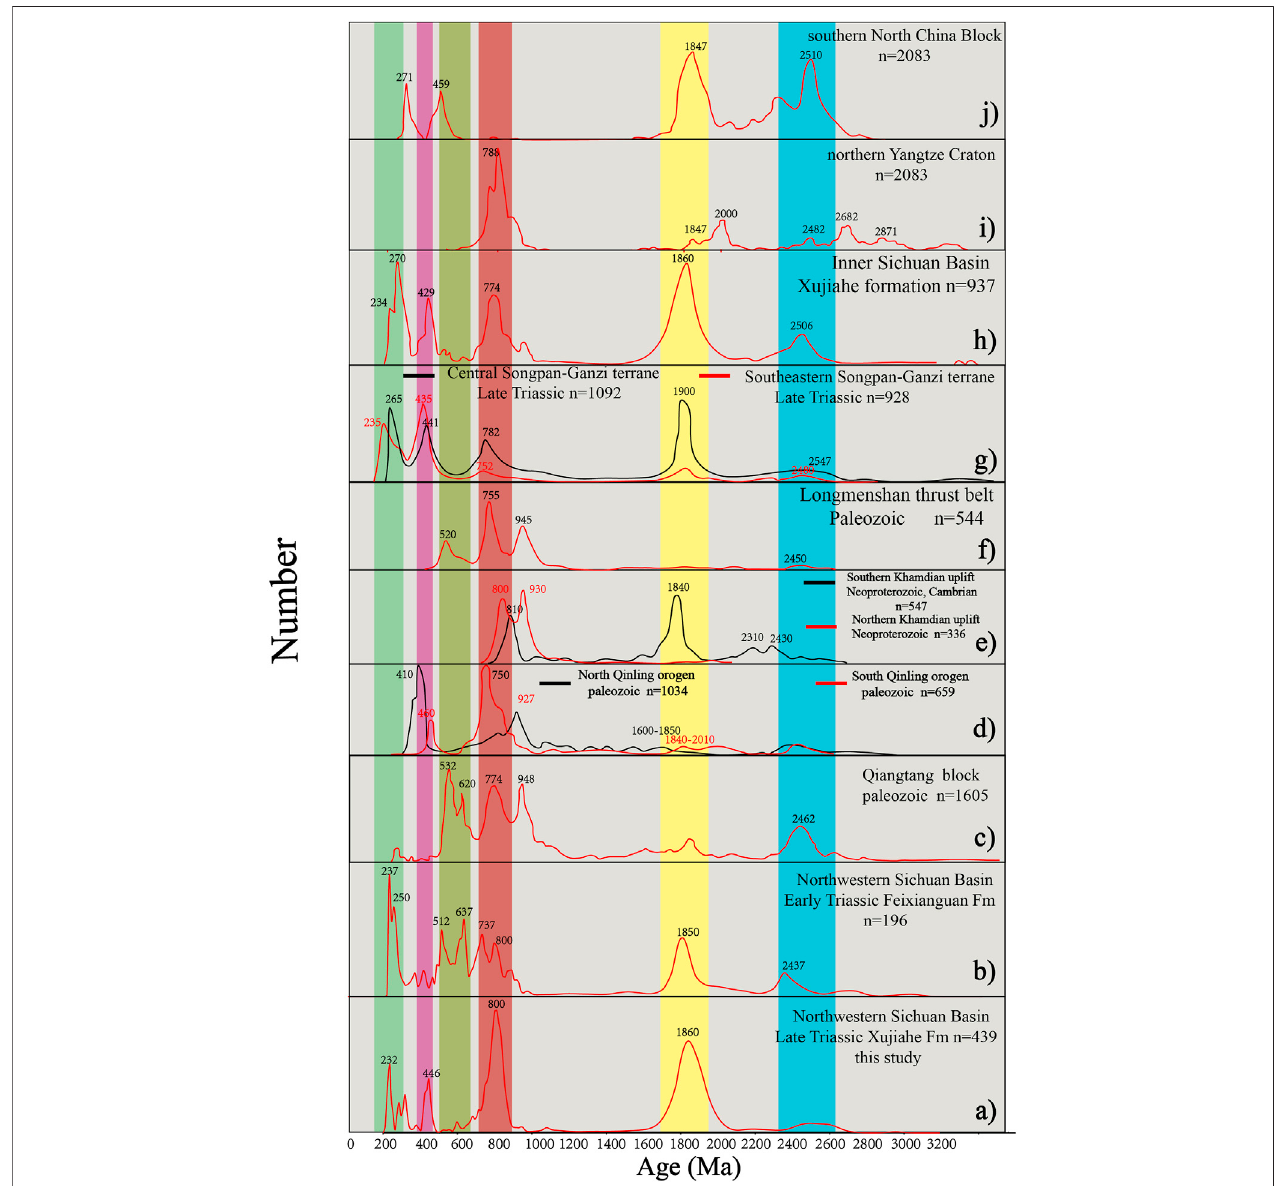
FIGURE3| RelativeprobabilityofdetritalzirconU – Pbagesforcomparisonwithadjacentpotentialsourceareas. (A) LateTriassicsandstonesand (B) EarlyTriassic sandstones in the Northwestern Sichuan Basin; (C) Paleozoic strata of Qiangtang Block (Gehrels et al., 2011); (D) red line: Paleozoic strata of South Qinling belt (Zhu etal.,2017;Shietal.,2013);blackline:PaleozoicstrataofNorthQinlingbelt(Shietal.,2013;Zhuetal.,2011); (E) redline:Neoproterozoicsedimentarystrata(Zhouetal., 2006;Sunetal.,2009);blackline:NeoproterozoicandCambriansedimentarystrata(Sunetal.,2009); (F) PaleozoicstrataofLongmenshanthrustbelt(Chenetal., 2011; Weislogel et al., 2010); (G) Late Triassic strata ofSongpan-Ganzi terrane (Weislogelet al., 2010); (H) inner Sichuan foreland basin (Luo et al., 2014; Li et al., 2016; Deng et al., 2008); (I) north Yangtze Craton (Shi et al., 2013; Shao et al., 2016); (J) Permian – Middle Triassic strata in the southern North China Block (Shi et al., 2013; Zhang et al.,